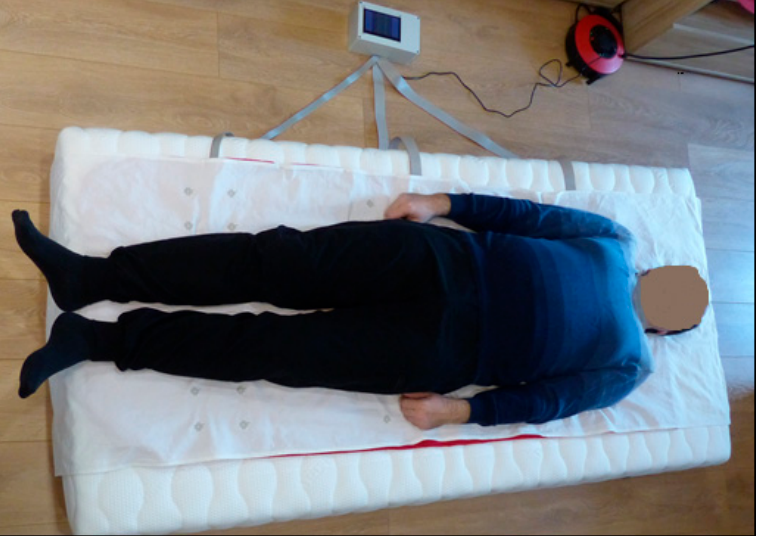
Figure 12. The experimental setup for the measurement with the e-textile mat. The sensor readings were displayed on the screen of the Raspberry Pi 4 minicomputer. The squares with the darkest colour corresponded to the passive sensors, and those with lighter ones to the activated ones. The motives that were obtained in the two postures of the human body are presented in Figure 13.